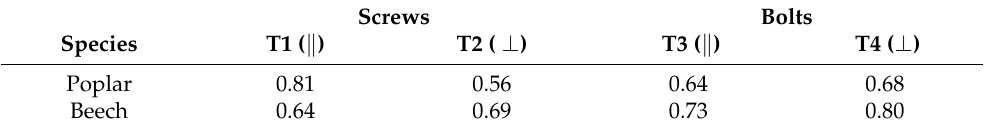
Table 5. Determination coefficient ( R 2 ) between ρ k and f h , k , exp depending on species and test.